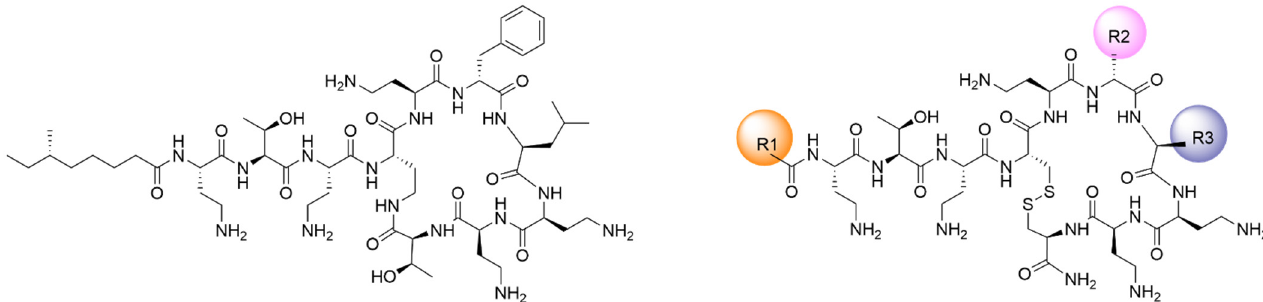
Figure 1. Design of novel polymyxin B analogues. Left : structure of natural polymyxin B; colistin (PxE) has a DLeu in position 6 instead of DPhe. Right : Synthetic scaffold; analogues have a disulfide isosteric insertion to mimic the spatial structure of natural polymyxins. R1: acyl chain C6 to C12; R2: DPhe/DLeu/DNle; R3: Leu/Nle.